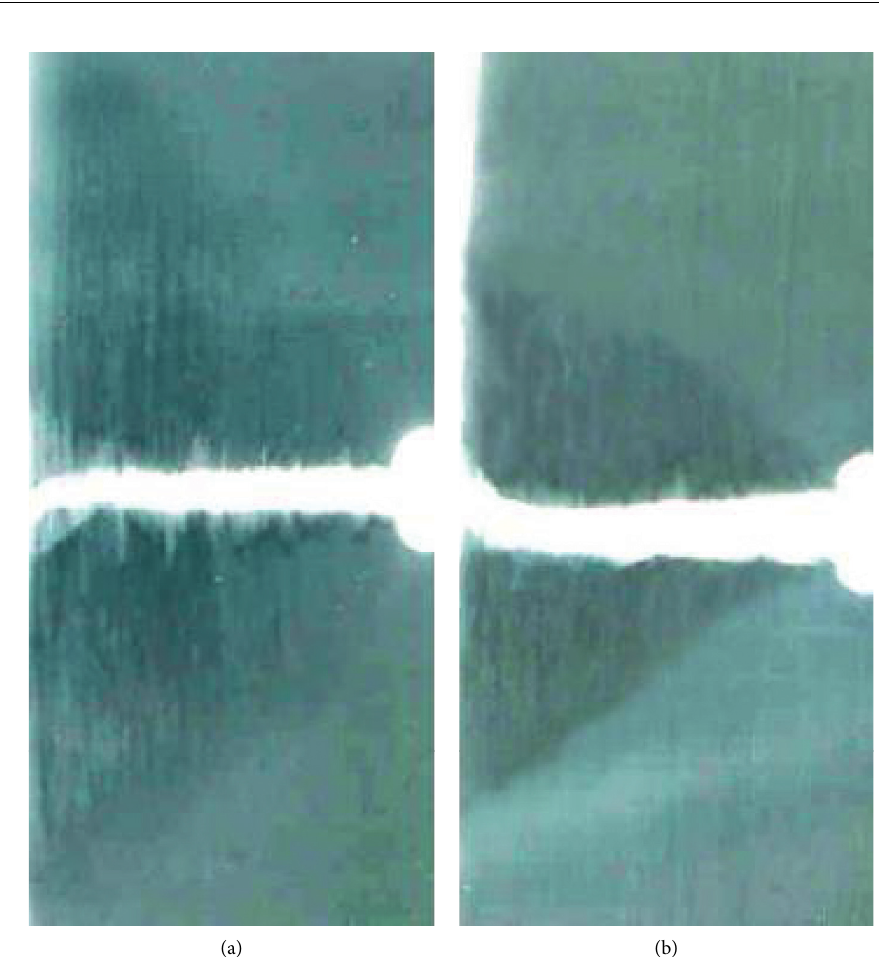
Figure 18: X-ray images of the damage zone in samples with 1/8in. Notch diameter of (a) type I hybrid FMLs and (b) type II hybrid FMLs